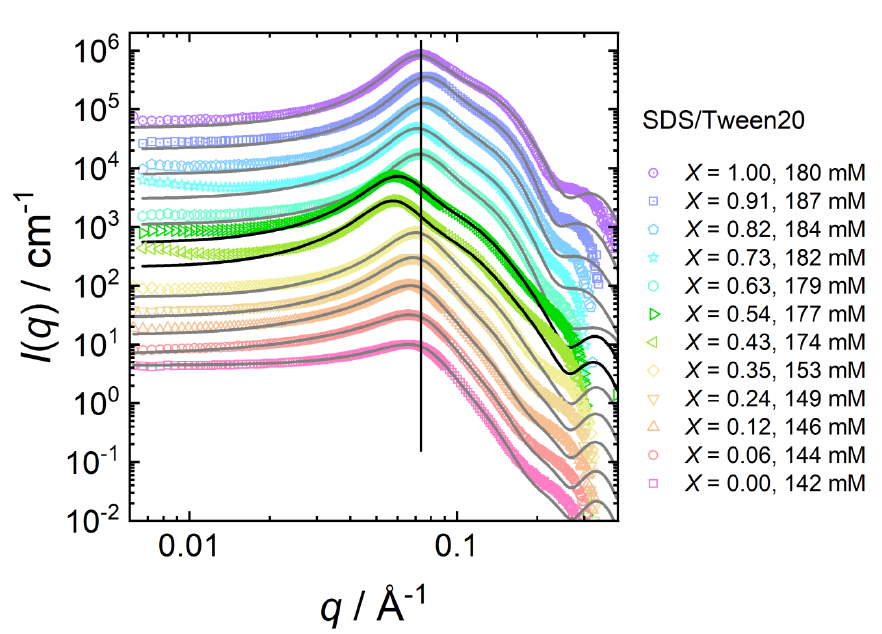
Figure 7. SANS data for mixed Tween20-SDS surfactant mixtures at similar surfactant concentrations but at varying mixing ratios X =[SDS]/([SDS]+[Tween20]). Symbols are experimental scattering data. The black solid lines are model fits to the data by Equation (1). Data sets are scaled with a factor of 3 n for clarity.